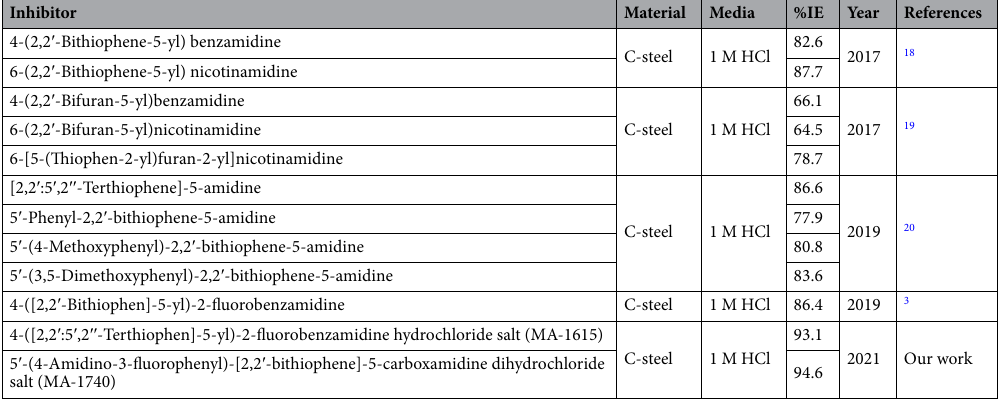
Table 1. Corrosion inhibition efficiencies by EIS of previously studied bichalcophene derivatives in